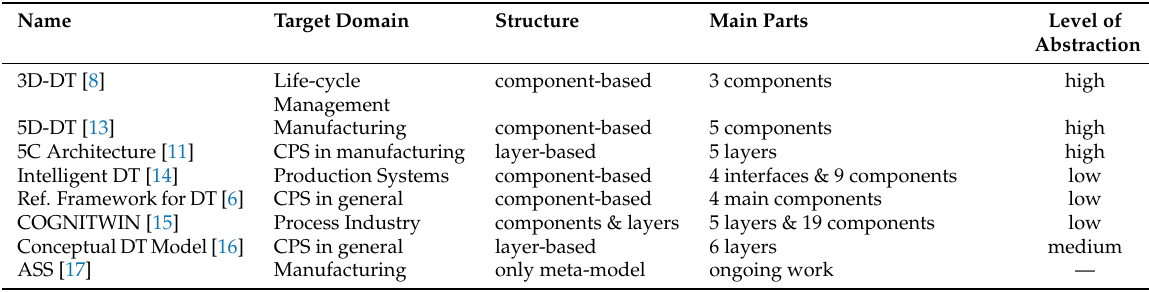
Table 1. Overview of concepts, architectures, and frameworks for Digital Twins